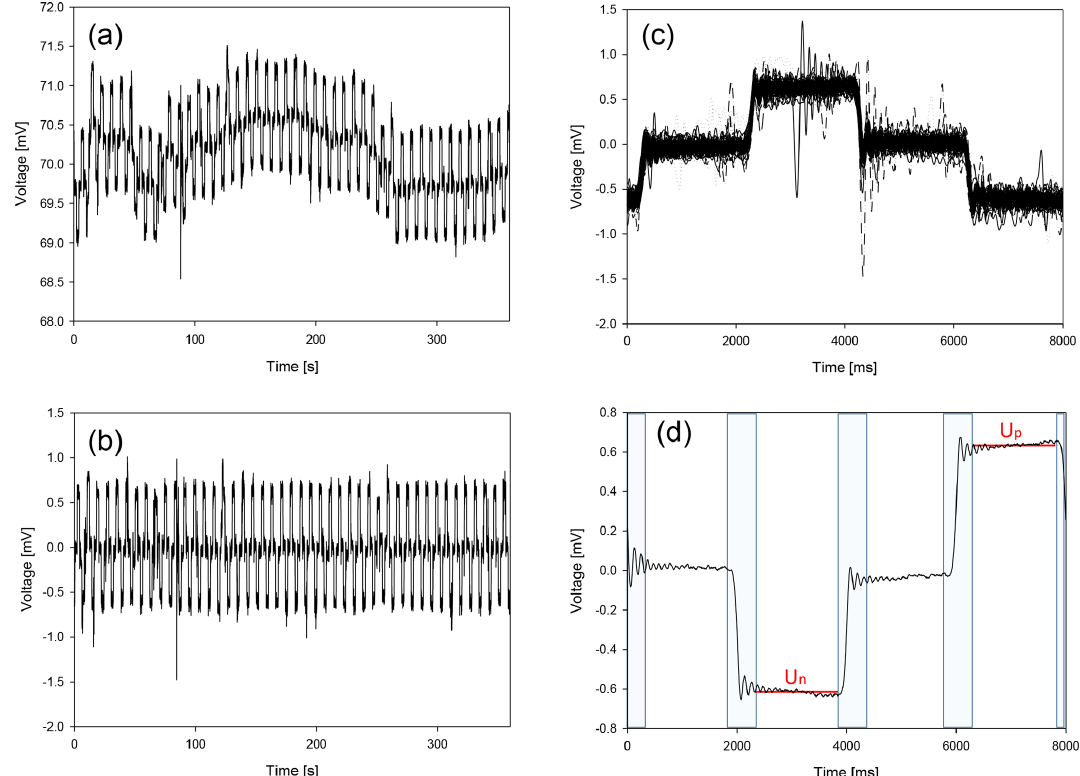
Figure 3. Processing steps of time series as an example. (a) Raw time series U(t) , (b) time series U dr (t) after drift correction, (c) stack distribution after cross-correlation, and (d) mean stacked signal with rejection windows to delete current switch effects (greyish areas) with positive ( U p ) and negative ( U n ) mean plateaus.